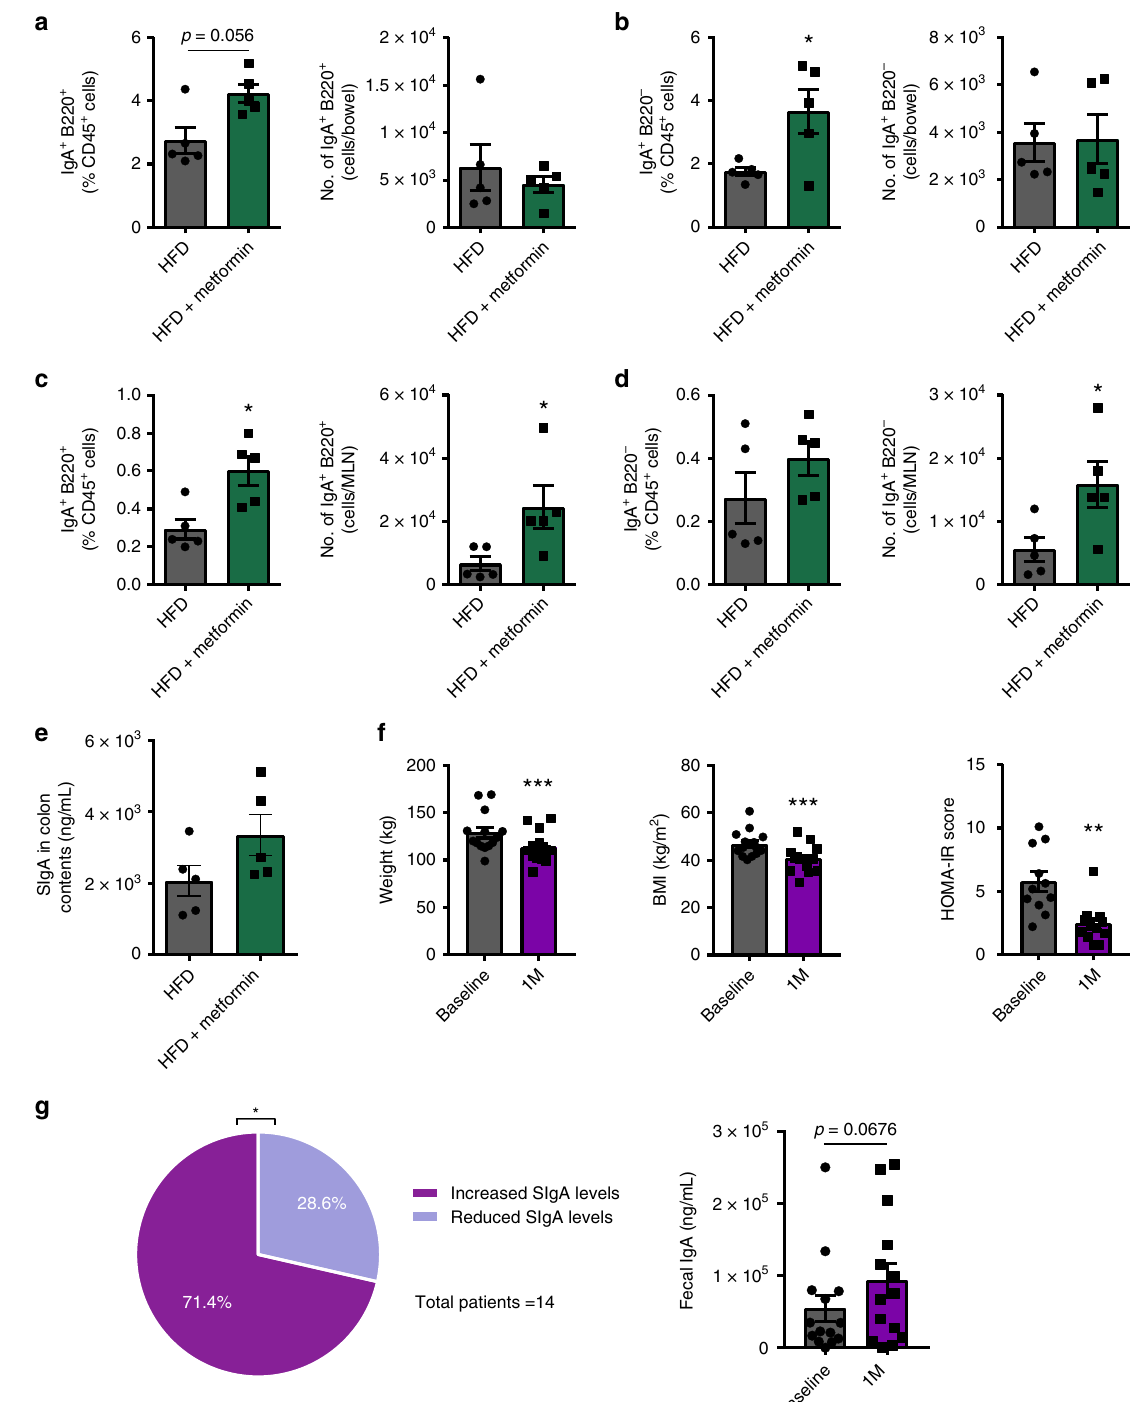
Fig. 8 Metformin treatment and bariatric surgery interventions can manipulate intestinal immunoglobulin A (IgA). Frequency and absolute numbers of IgA- producing a B cells (B220 + ) and b plasma cells (B220 − ) in the colon of high fat diet-fed mice treated with or without metformin in drinking water (300 mg kg − 1 per day) for 14 weeks ( n = 5/group). Frequency and absolute numbers of IgA-producing c B cells (B220 + ) and d plasma cells (B220 − ) in the colon draining mesenteric lymph node (MLN) ( n = 5/group). e Colonic secretory IgA (SIgA) levels in HFD-fed mice treated with or without metformin in drinking water for 14 weeks ( p = 0.1). f Weight (left), body mass index (BMI) (middle), and homeostatic model assessment-insulin resistance (HOMA-IR) score (right) of obese patients at baseline and 1 month post-bariatric surgery ( n = 14 patients; Wilcoxon ’ s matched-pairs test). g Left: Representative pie chart demonstrating number of patients with increased vs. decreased fecal IgA 1 month post-bariatric surgery ( p = 0.02 χ 2 chi-square test) and Right: total fecal IgA levels at baseline and one month post surgery ( n = 14 patients, p = 0.0676 Wilcoxon ’ s matched-pairs test). Data are means± SEM. * denotes p < 0.05, ** denotes p < 0.01, and *** denotes p <